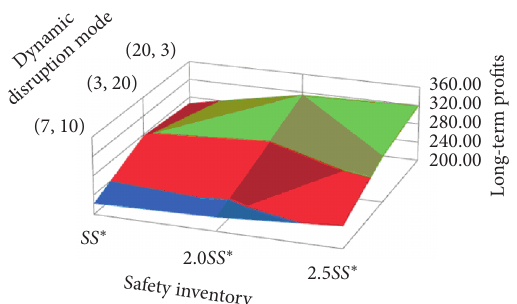
Figure 3: The impact of dynamic disruption modes and safety inventory policies on the long-term